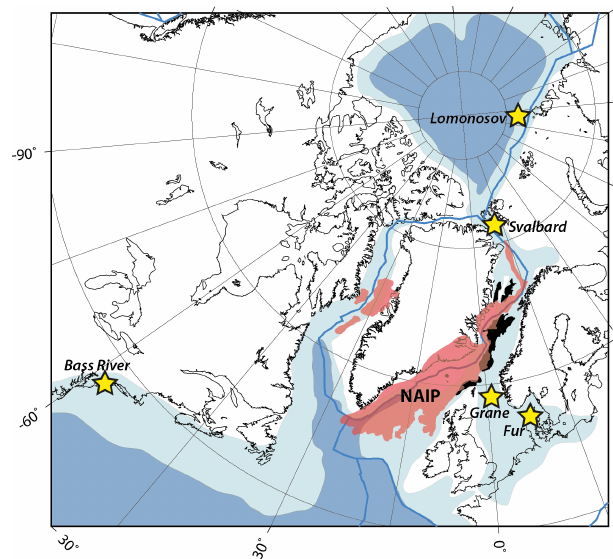
Figure 1. A regional plate reconstruction at 56Ma showing the sample sites used in this study. Each sample site is shown by a yellow star. Palaeo-shorelines and marine seaways are from Golonka (2009). Present-day coastlines are shown in black, while dark blue lines denote plate boundaries. Shelf areas are shown in light blue, while ocean basins are in dark blue. The red areas show the known extent of subaerial and submarine extrusive volcanism of the North Atlantic Igneous Province (NAIP) at this time (Jones et al., 2016). The black areas show the known extent of NAIP sill intrusions in sedimentary basins (Planke et al., 2005; Rateau et al., 2013; Reynolds et al., 2017). Note that the identification of sills be- neath extrusive volcanics is hampered by poor seismic retrievals. The figure was created with the help of Grace Shephard using the open-source plate tectonics software GPlates (Boyden et al., 2011; Gurnis et al., 2012) based on modifications to the reconstruction model (Shephard et al., 2013) and plotted with Generic Mapping Tools (Wessel et al.,